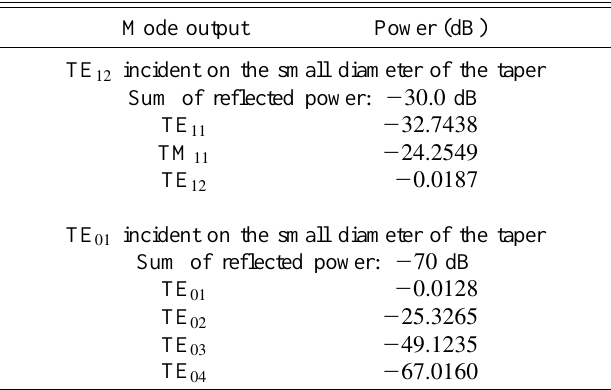
TABLE II. The simulated response of the arc taper.